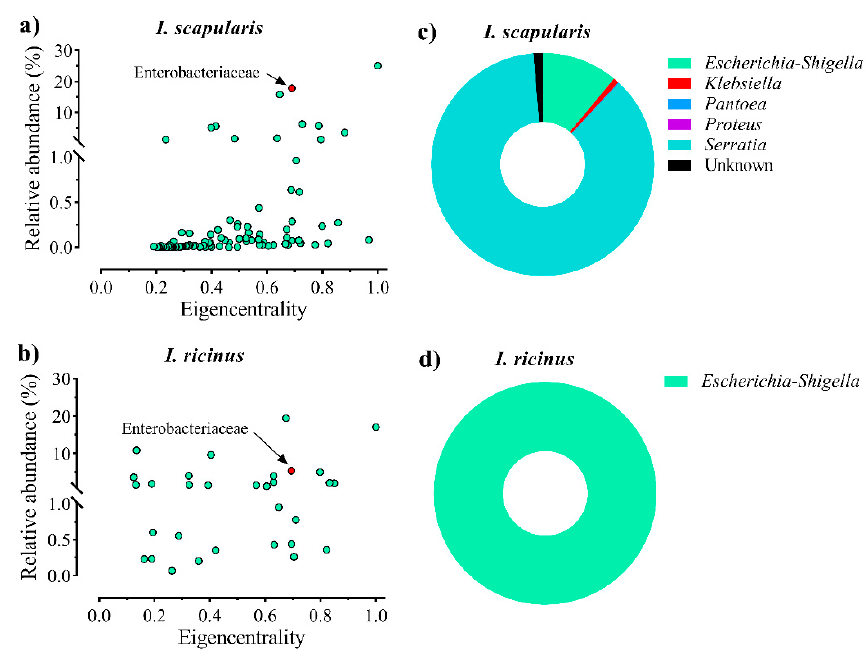
Figure 2. Eigencentrality and relative abundance of bacterial families in I. scapularis and I. ricinus microbiota. Relative abundance of all bacterial families was plotted as a function of their eigencentrality in the co-occurrence networks of ( a ) I. scapularis and ( b ) I. ricinus microbiota. Only families with at least one significant correlation with other nodes in the networks are displayed. Circles represent bacterial families and Enterobacteriaceae was highlighted (red color). The taxonomic composition (%) of Enterobacteriaceae according to bacterial genera are represented in donut chart for both ( c ) I. scapularis and ( d ) I. ricinus microbiota .